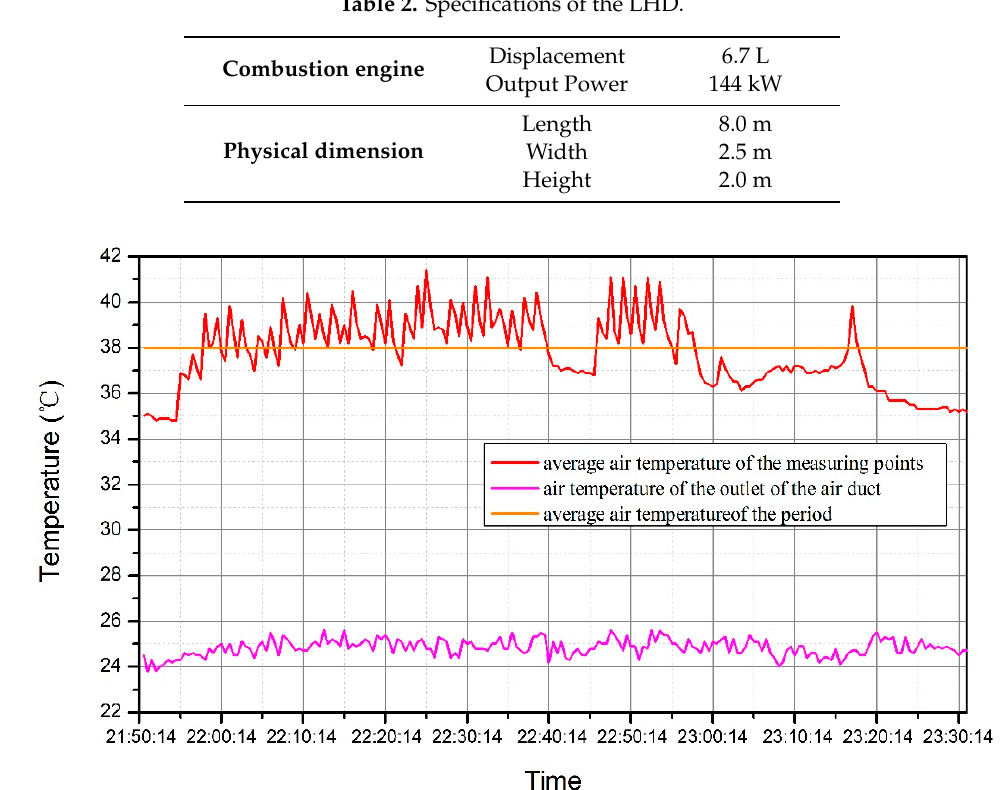
Figure 6. Variation of air temperature with time from 21:50 to 23:30.